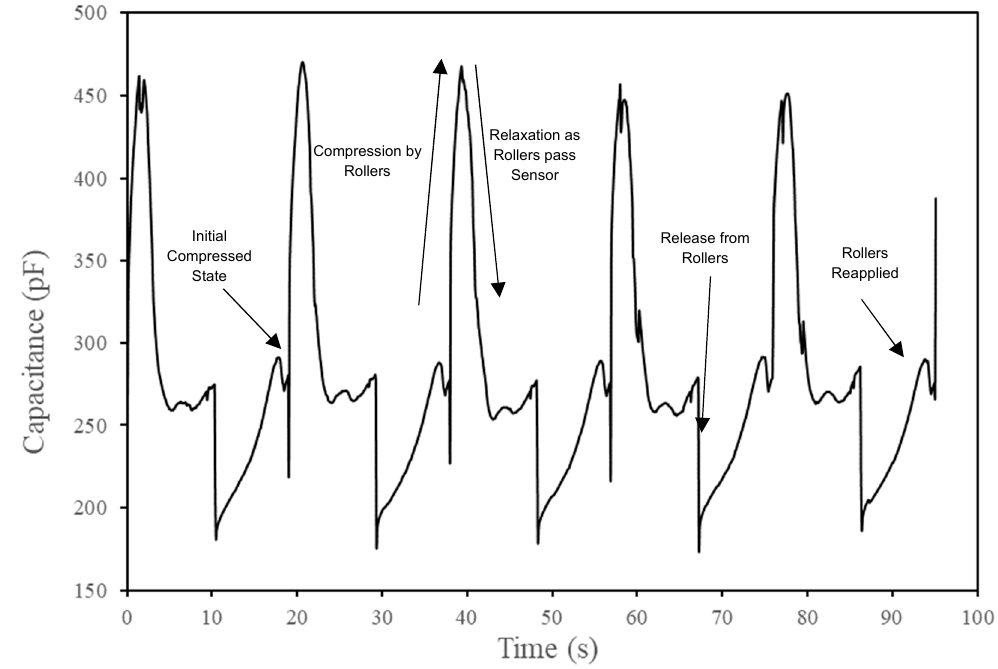
Figure 10. Capacitive signal trace from monitoring silicone in vitro stomach model peristaltic compression, simulating gastric motility. Labels indicate the different phases of motion and signal detection.